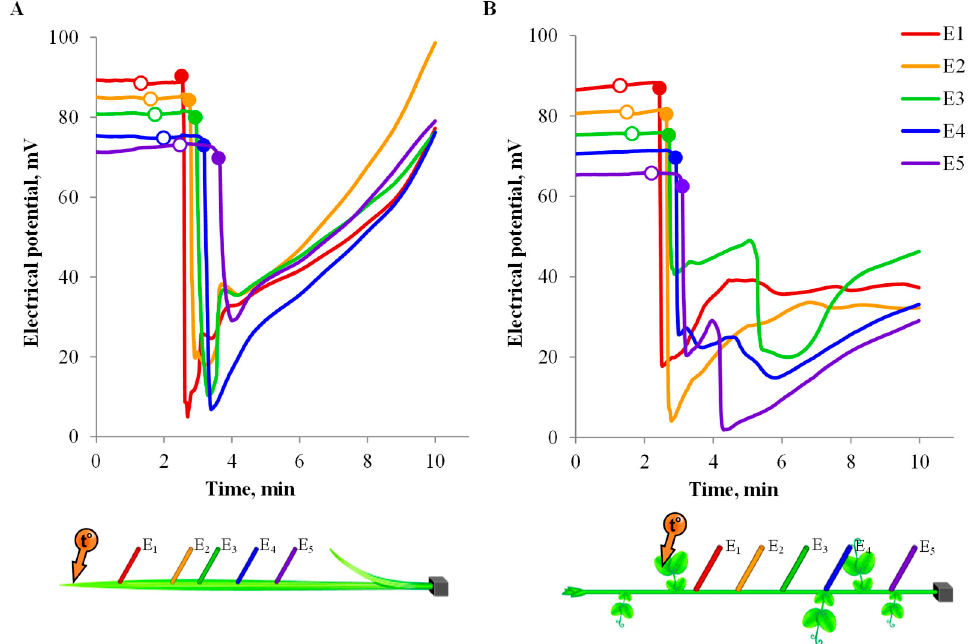
Figure 3. The typical extracellular multichannel record of variation potential induced by heating of the wheat leaf tip ( A ), or heating of the top leaf of the pea seedling ( B ). The circles show the start time of the reaction, calculated by machine processing. Open circles, reaction start at high scales (100); filled circles, at optimal scales (10 and 5 for wheat and pea, respectively). The scheme of induction and recording of variation potential is shown below. The distances between the stimulated area in wheat and the electrodes E1, E2, E3, E4, E5 were 1.5, 3, 4.5, 6, and 7.5 cm, respectively. The distances between the stimulated area in pea and the electrodes E1, E2, E3, E4, E5 were 3, 4.5, 6, 7.5, and 10.5 cm, respectively.